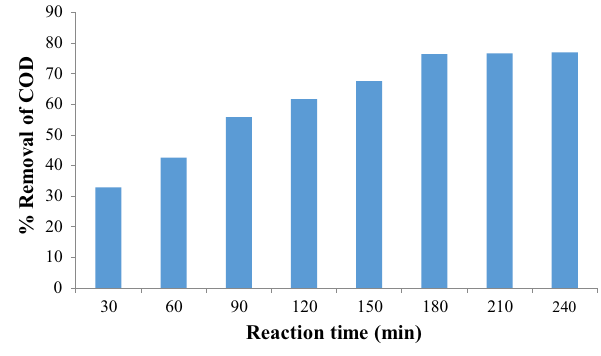
Fig. 2 Percentage removal of COD in Fenton after distillation. Exper- imental conditions: FeSO 4 concentration (mg/L): 0.027 g, H 2 O 2 con- centration: 0.9 ml, pH: 3, initial COD: 34,000 mg/L, working volume: 250 ml